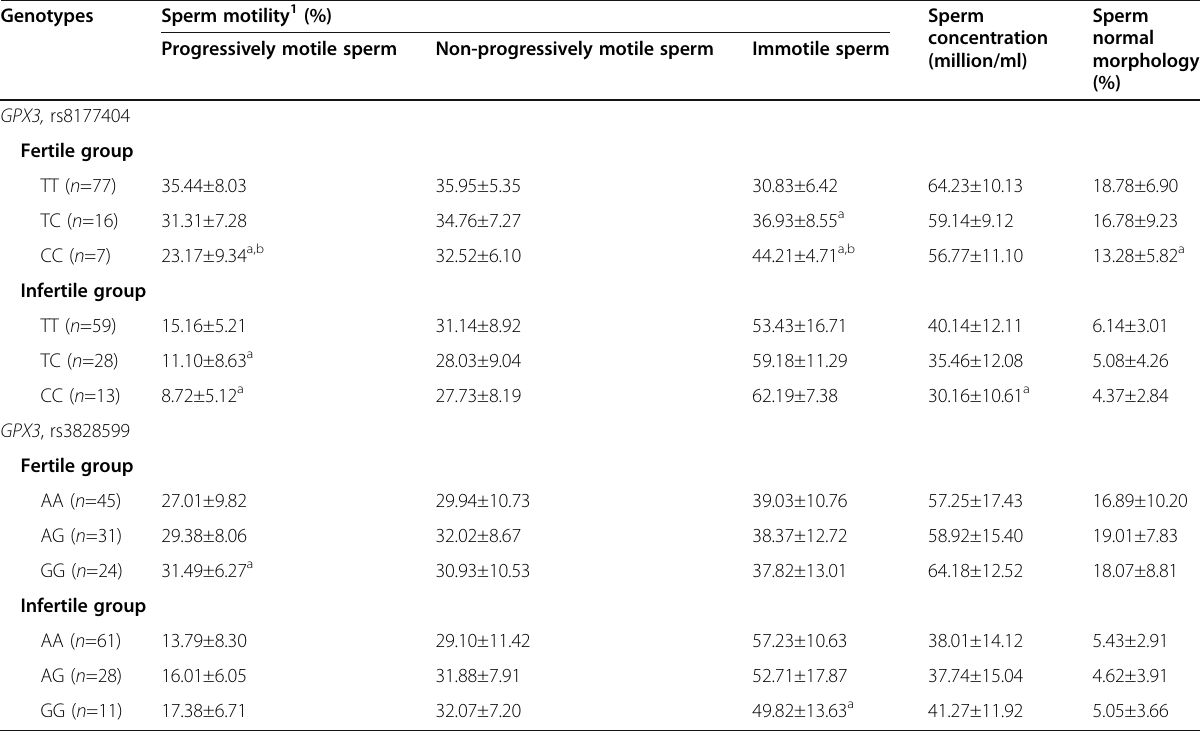
Table 6 Semen parameters according to the various genotypes of rs8177404 and rs3828599 polymorphisms in fertile ( n =100)